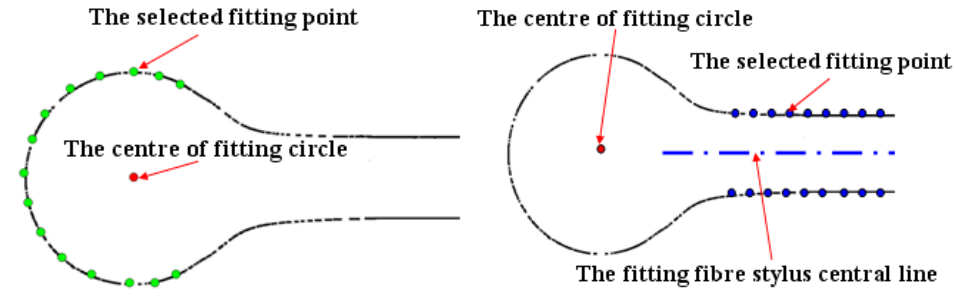
Figure 3. Fitting method of 2D diameter, 2D roundness and 2D offset